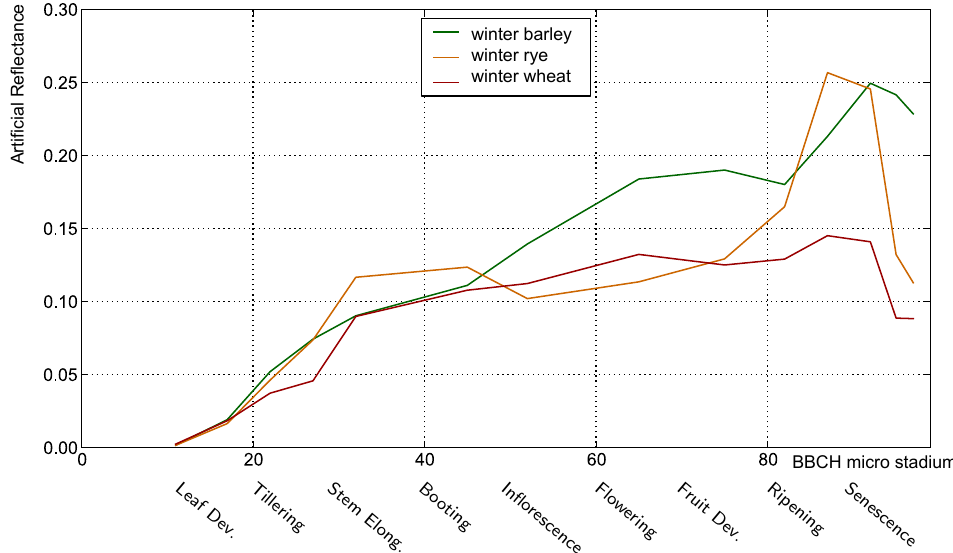
Figure 3. Artificial reflectance of winter barley (green), winter rye (yellow) and winter wheat (red) with constant artificial optical properties during the different BBCH growth stages.